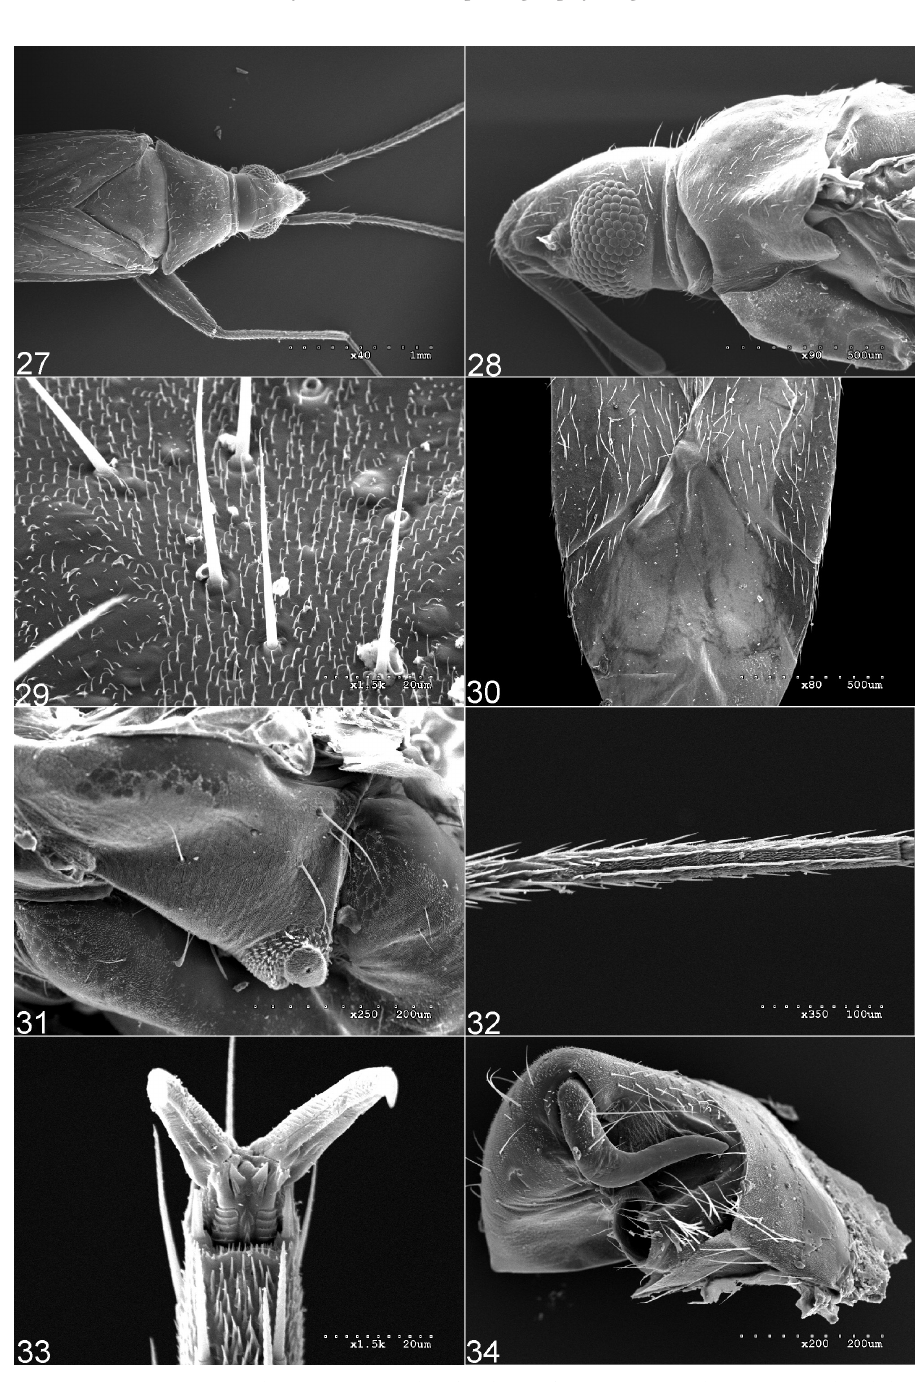
Figures 27–34. Scanning electron micrographs of Fulvius subnitens : 27 Dorsal view 28 Head and tho- racic pleura (left lateral view) 29 Texture and vestiture of frons 30 Structure, texture, and vestiture of hemelytron 31 Metepisternum 32 . Metatarsus 33 Pretarsal structure 34